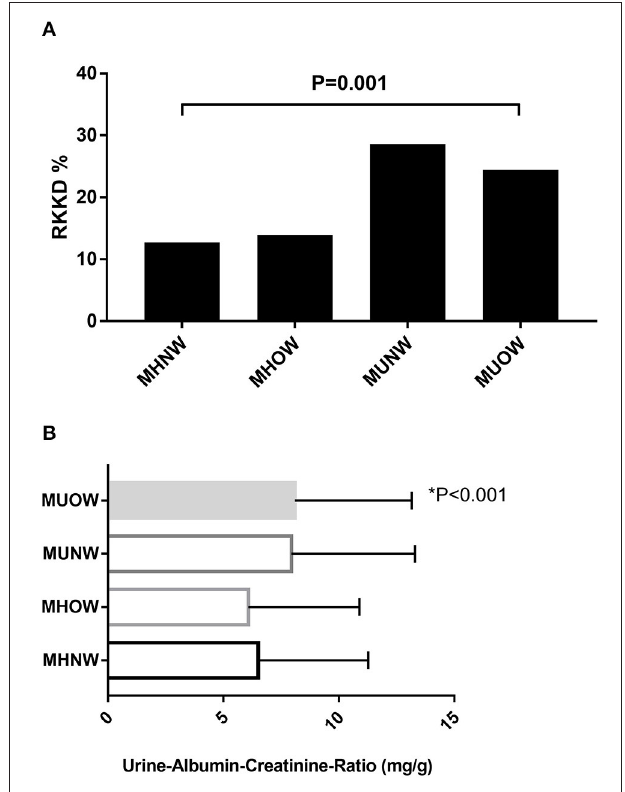
FIGURE 1 | (A) Overall RKFD rate according to MBCS. (B) Overall UACR according to MBCS. MBCS, metabolic body composition status; RKFD, rapid kidney function decline; UACR, urinary albumin-creatinine